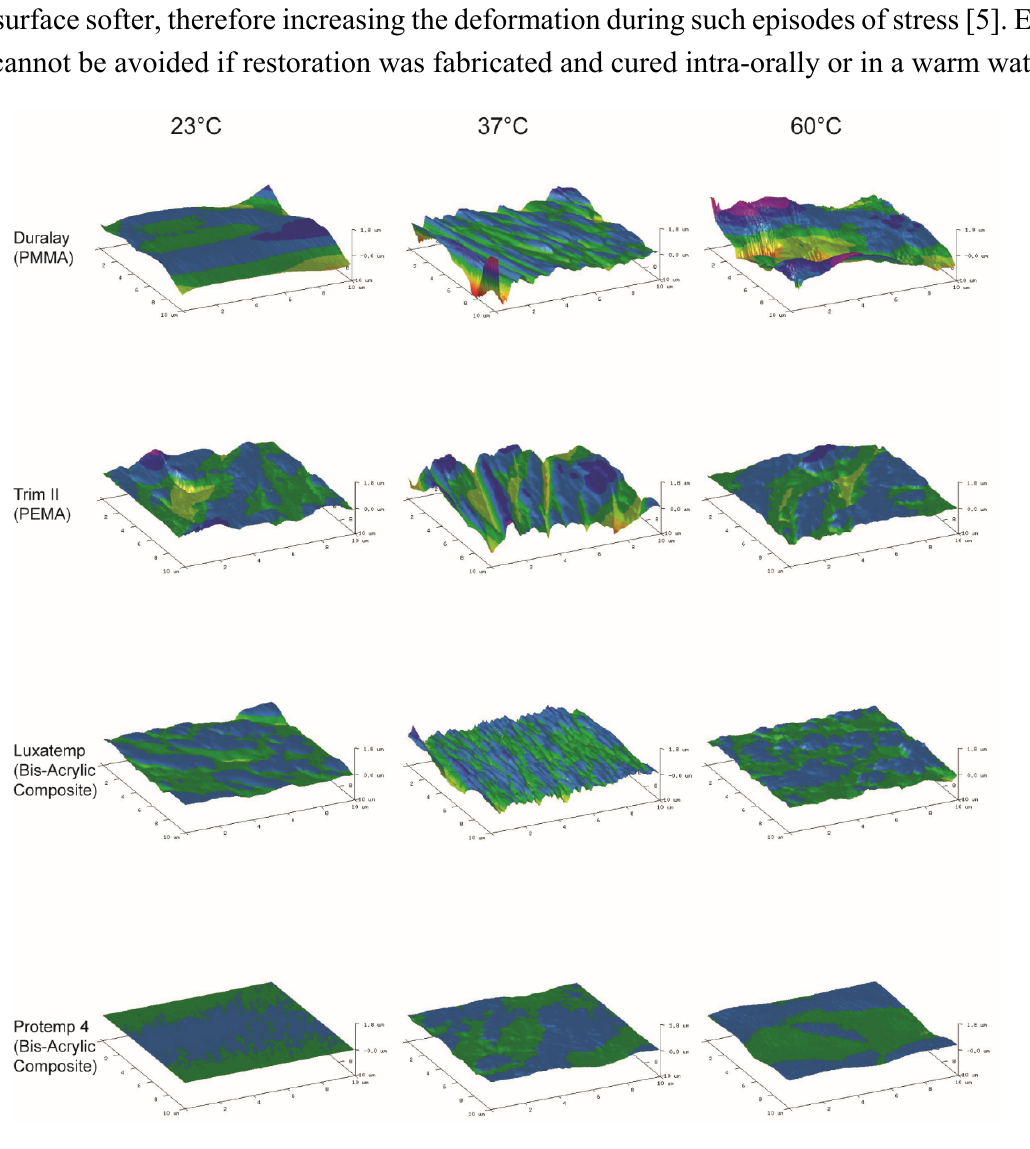
Figure 3. Three-dimensional Atomic Force Microscopy (AFM) tapping-mode images of the material